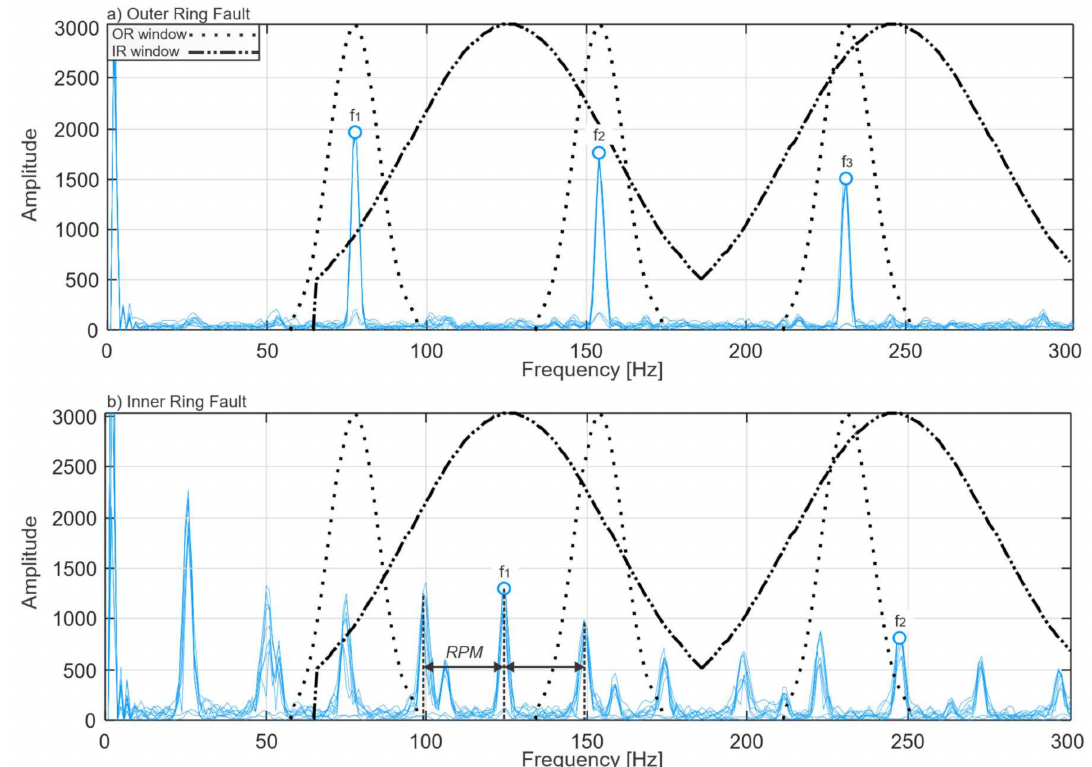
Figure 11. Defect frequency harmonics for: ( a ) Outer ring faults; ( b ) Inner ring